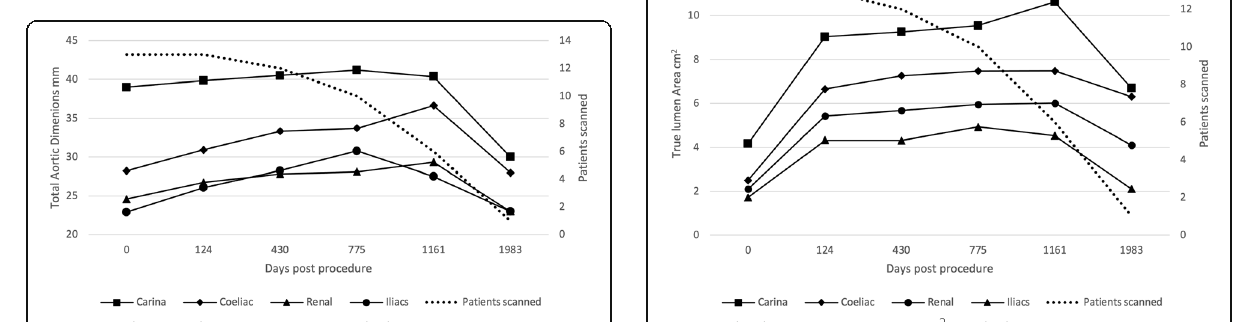
Fig. 7 Total aortic dimensions (mm) excluding cases